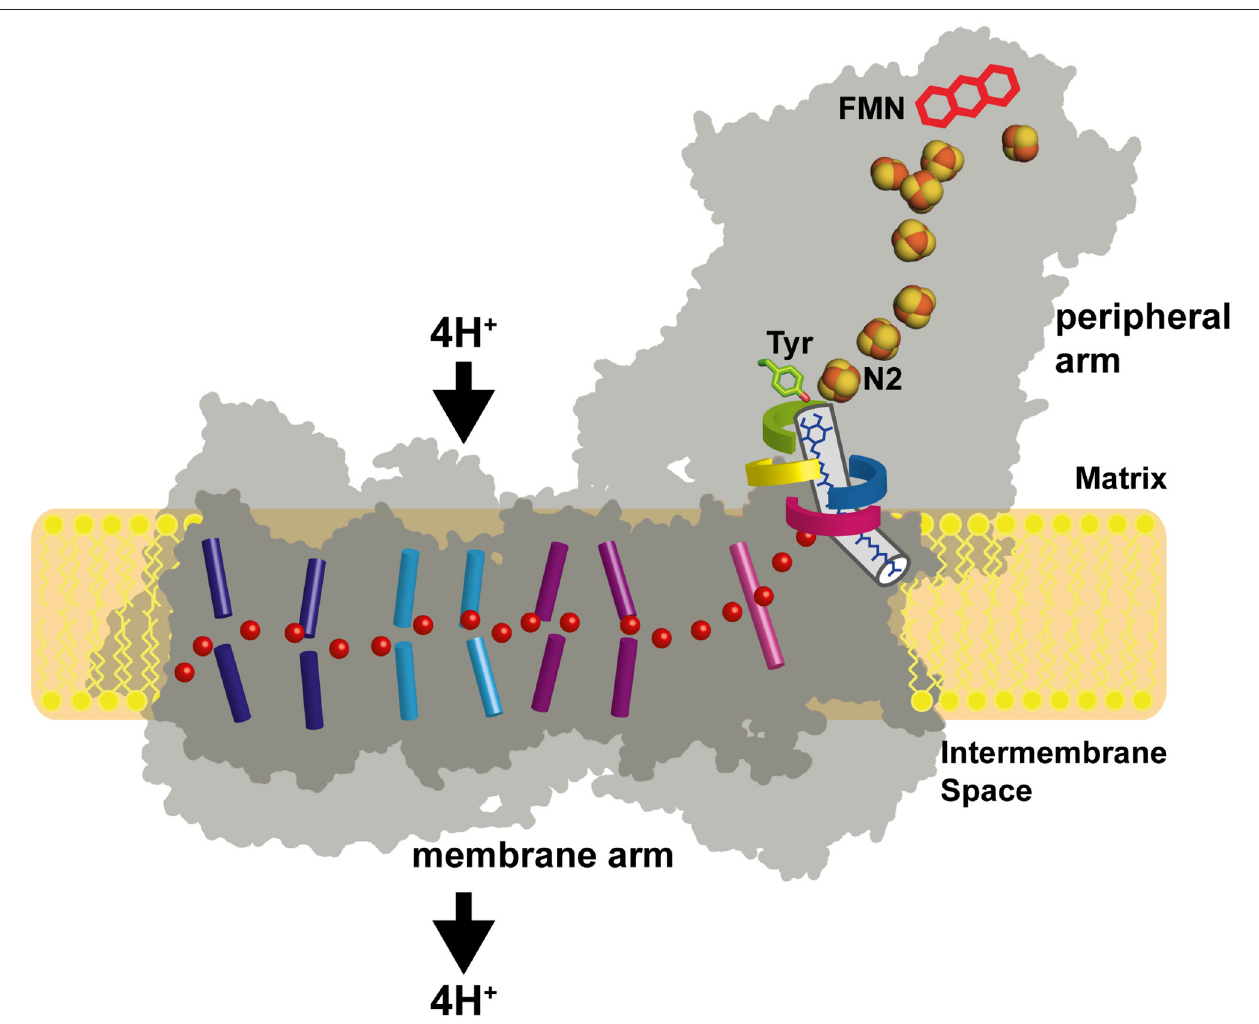
FIGURE 1 | Architecture of complex I. The primary electron acceptor FMN is connected by a chain of FeS clusters with the Q reduction site near FeS cluster N2. Q moves in a tunnel between the active site and the membrane. A hydrophilic axis (red dots) connects the Q module with the proton pumps. Its initial section is called the E channel due to the presence of several strictly conserved glutamates in subunit ND1. Loops of subunits NDUFS2 (green), NDUFS7 (blue), ND1 (red), and ND3 (yellow) line the Q access pathway and the interface between the membrane arm and the peripheral arm. Concerted conformational changes in the loop cluster are thought to play a key role in the coupling